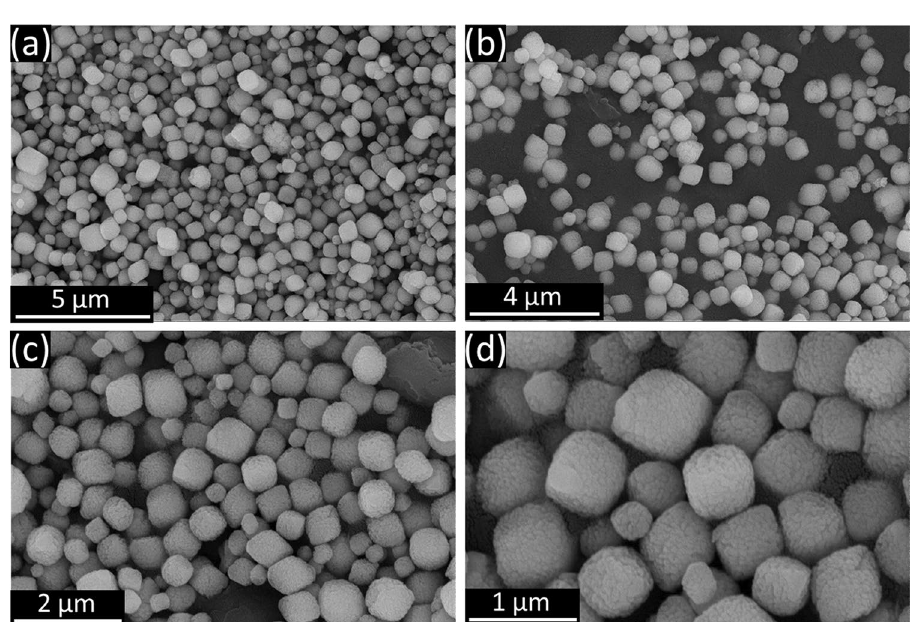
Figure 2. SEM images of α-Fe 2 O 3